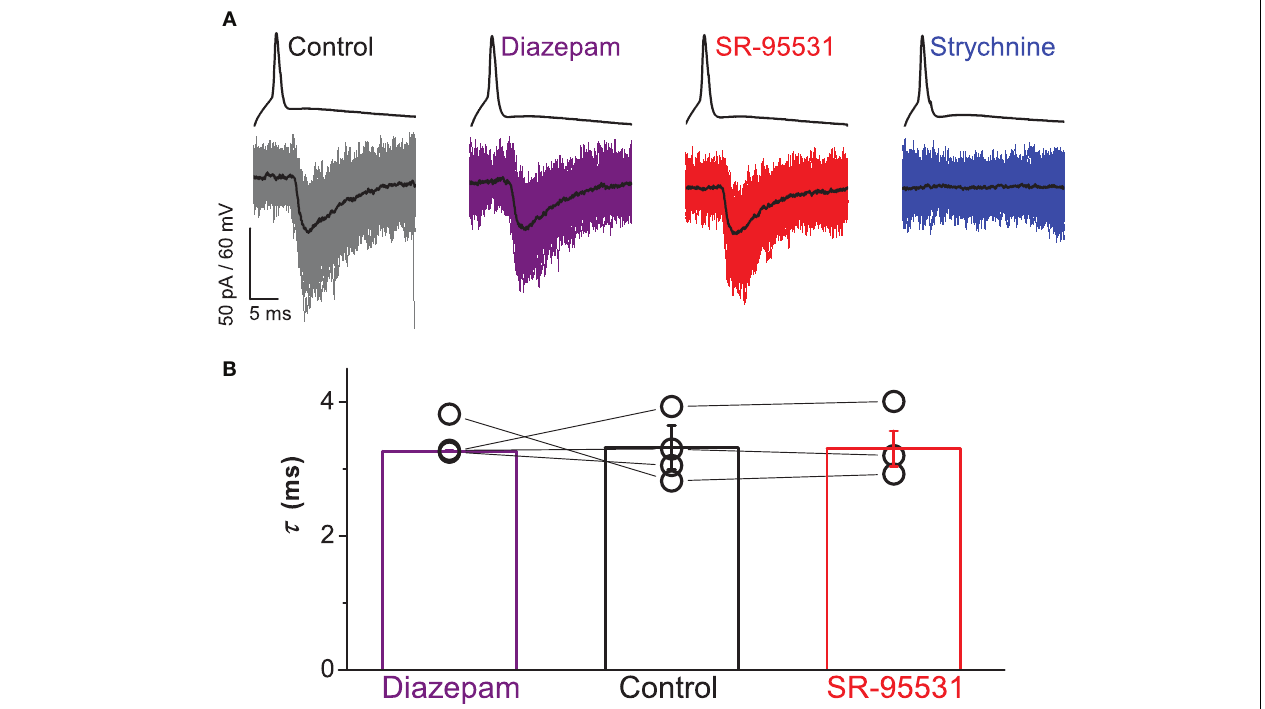
FIGURE 2 | Paired recordings showed no contribution of GABA to evoked IPSCs. Traces in (A) illustrate responses from a connected pair representing a single spike elicited in the interneuron above and the evoked IPSCs recorded from the motoneuron below with the mean current overlayed in black.